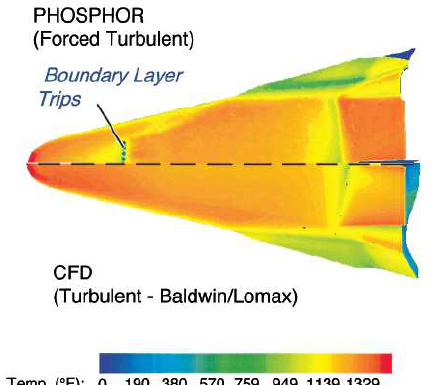
Figure 66. Comparison of extrapolated turbulent experimental data with predicted CFD data. Taken from Horvath et al .